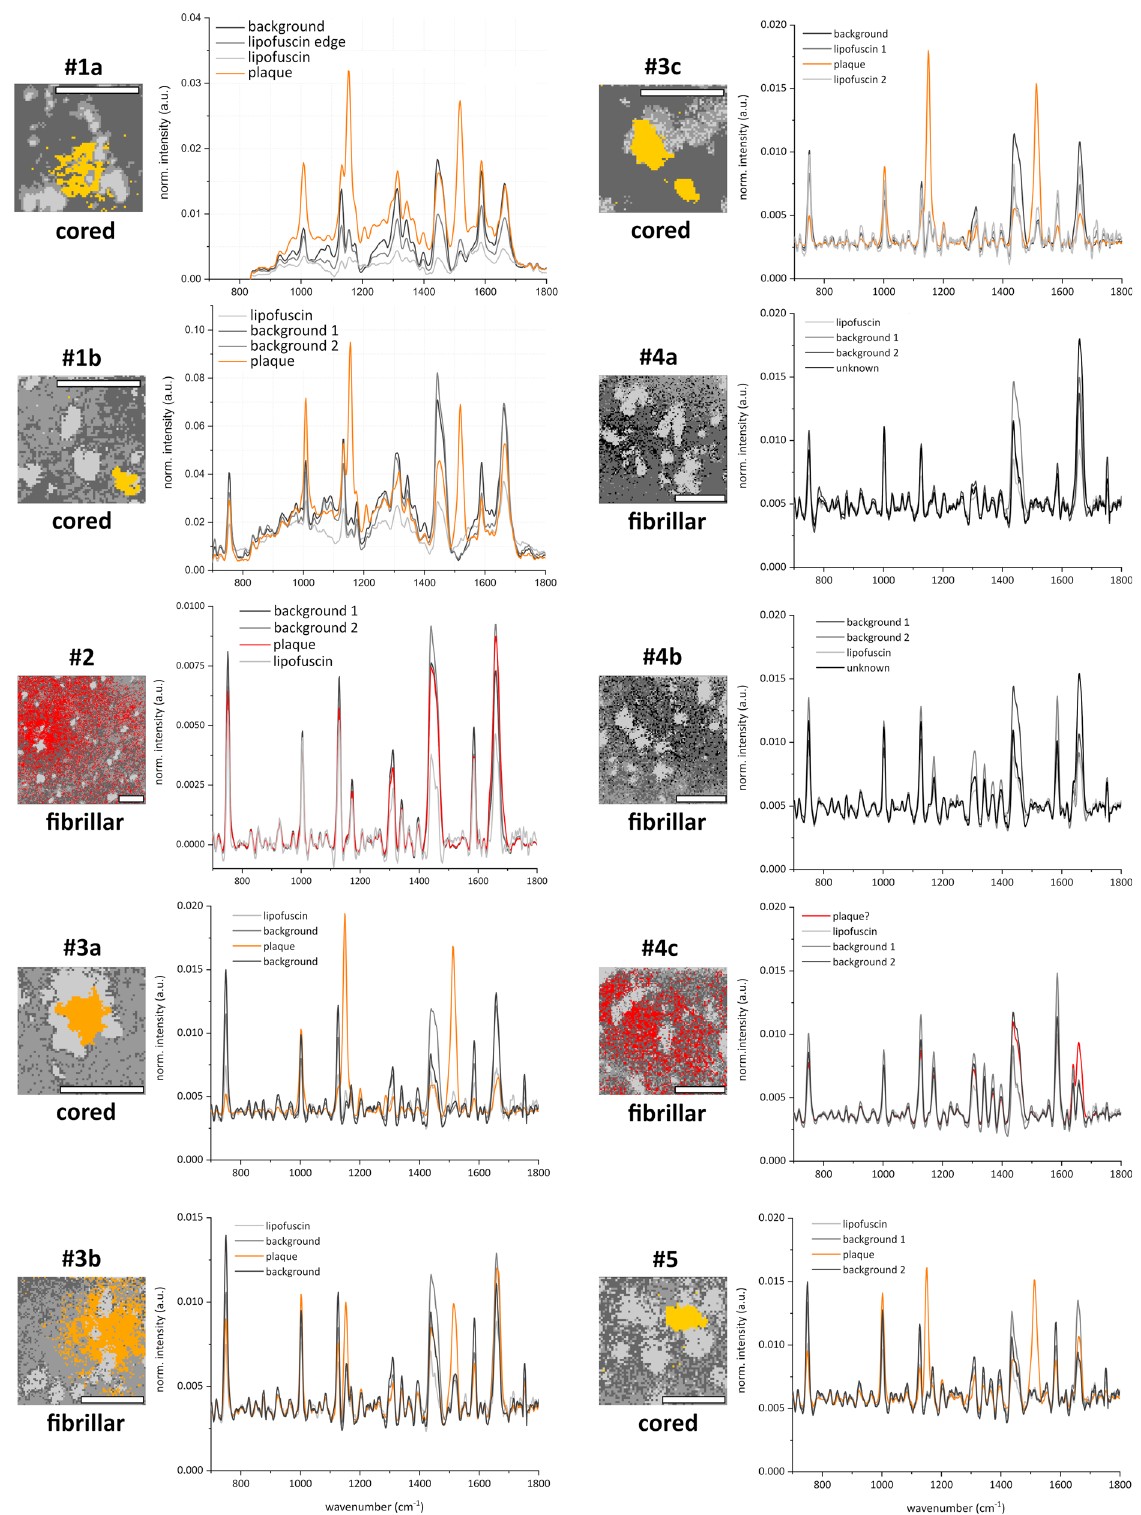
Fig. 6 Four-cluster images of all plaques and their corresponding spectra after complete data processing. The orange solid lines, obtained from the cored plaques and from fi brillar plaque #3b, exhibit a distinguishable spectrum with clear carotenoid-associated peaks. However, in plaques #2 and #4 (a – c) no carotenoid peaks were detectable. The red area, which largely overlaps with the later con fi rmed plaque location, corresponds to the spectrum (red line) on the right which is not associated with carotenoids. (The whole recorded spectra of #1a including the CH-stretch range can be found in the Supplementary Information, Fig. S11.) Scale bars: 40 µ